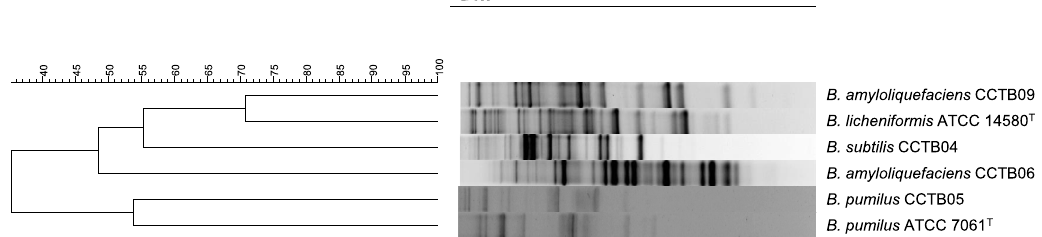
Fig. 1. Rep-PCR fingerprinting and 16S rRNA-based clustering of the isolates employed in this